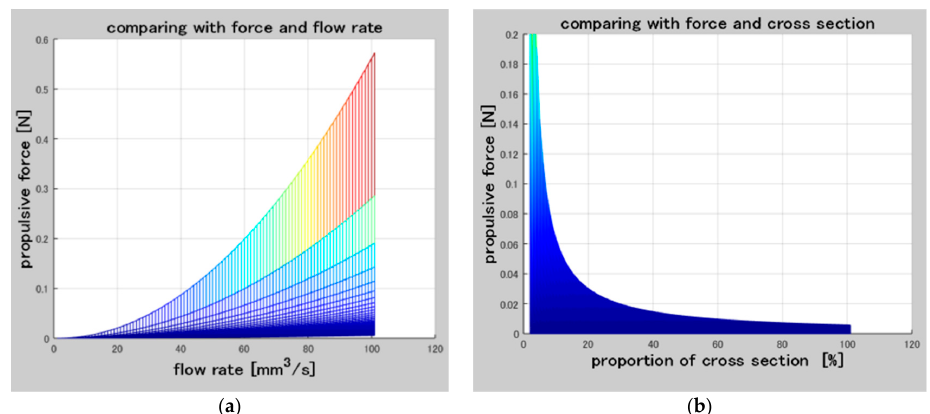
Figure 12. ( a ) Relationship between the propulsive force and flow rate; ( b ) Relationship between the propulsive force and proportion of cross section.